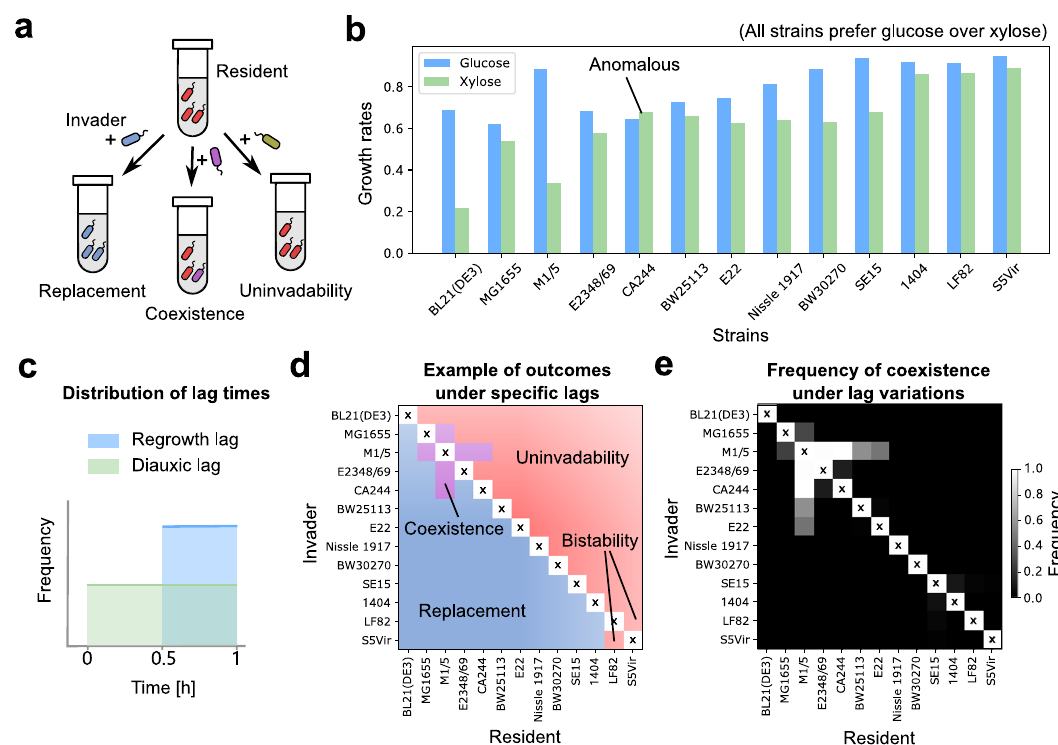
Fig. 6 Predicting pairwise co-culture outcomes of diauxic laboratory E. coli strains. a Schematic of pairwise invasion simulations. For each invasion event, a small amount of an invader strain was added into the monoculture of the resident strain. The system was then serially diluted until reaching a steady state. We simulated these pairwise invasions using E. coli strains discussed in ref. 46 , where their growth rates and yields were measured in experiments. An invader either replaces the resident, coexists with it, or is unable to invade. b Growth rates of the 13 laboratory E. coli strains on glucose (blue) and xylose (green), obtained from Barthe et al. 46 . Note that one of the strains is anomalous. c Distribution of the initial lags (uniform between 0.5 and 1 h) and diauxic lags (uniform between 0 and 1 h) used in simulations. In each of 100 simulation runs, we randomly sampled the lag times of each strain, and performed exhaustive pairwise invasion simulations. d An example of competitive outcomes, showing 1 of the 100 runs. In most circumstances, the invader beats the resident (blue) or fails to invade (red). Coexistence (purple) or bistability can also occasionally happen. e Frequency of coexistence. A strain on the y -axis invades the monoculture of a strain on the x -axis, and the greyscale represents the frequency that both strains survive in the steady state among 100 runs where lag times were